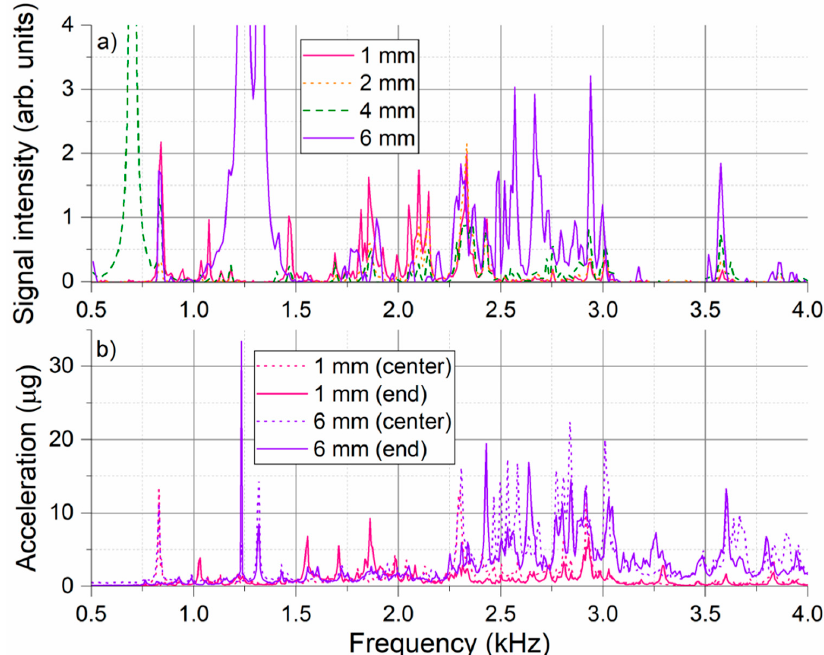
Figure 9. Signal spectra recorded in the pipe zone 2 for the measurement series with different size leaks at the same pressure level of 10 bars; ( a ) Overall (time- and position-averaged) DAS signal spectra from the pipe zone 2; ( b ) Time-averaged signal spectra from the reference accelerometer placed in the middle of the pipe zone 2 close to the leak (center) and at the edge of the pipe zone close to the flange